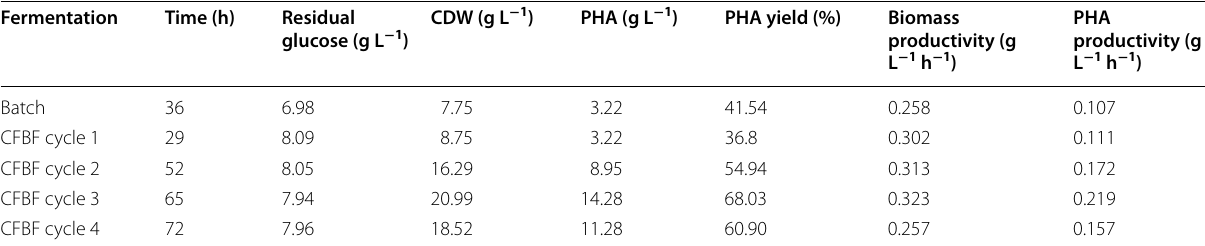
Table 4 Growth and product kinetic parameters of B. thuringiensis during the batch and cyclic fed-batch fermentation Fermentation